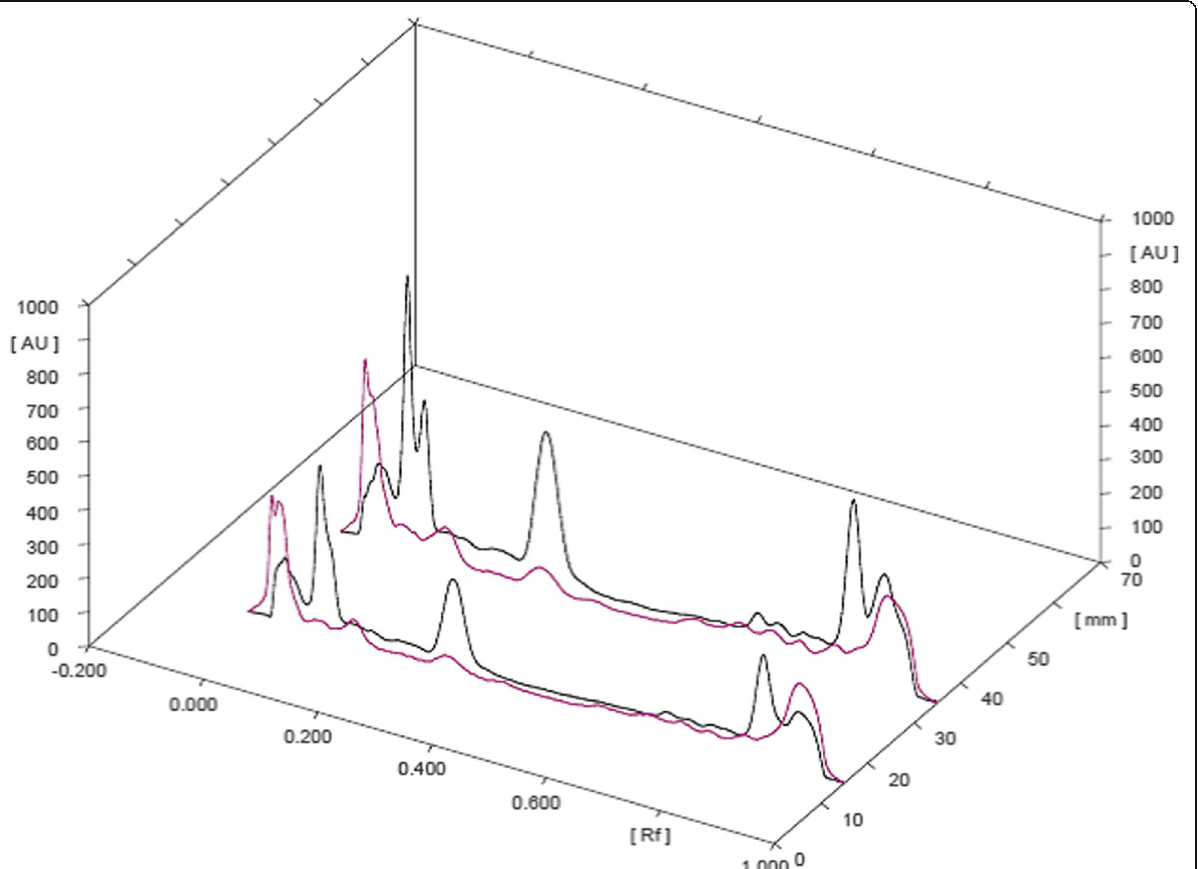
Fig. 1 3D overlay of HPTLC chromatogram of all tracks, at all